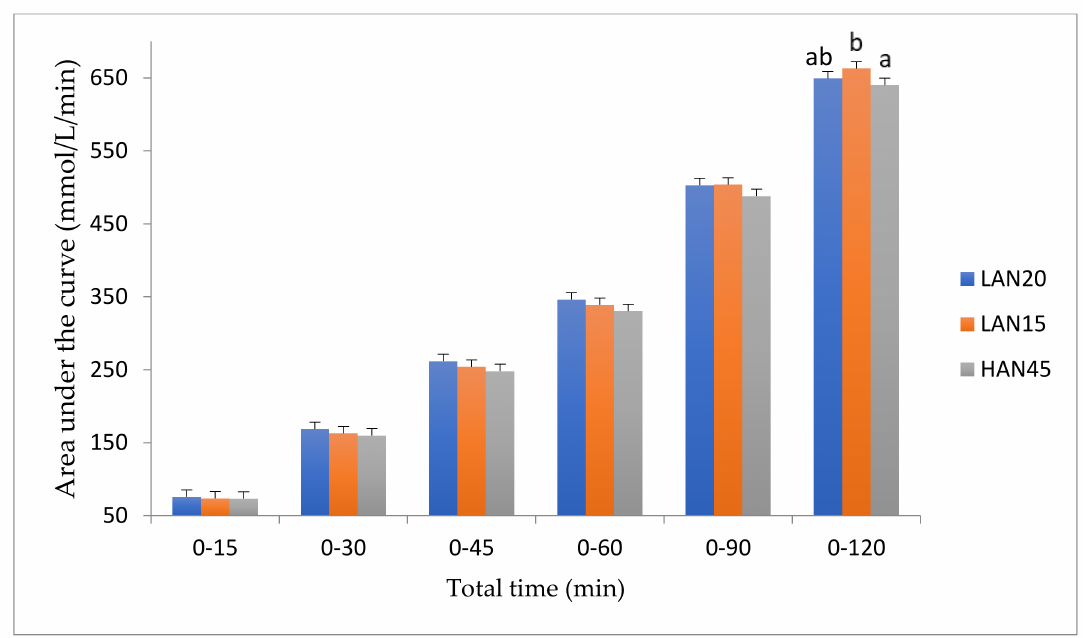
Figure 3. P1 study: Area under the blood glucose curve over 120 min following the ingestion of test noodles containing 15%, 20% and 45% amylose. Blood glucose total area under the curve for high amylose noodles (45%) was significantly lower compared to low amylose noodles (15%) ( p = 0.021). Data presented as mean ±